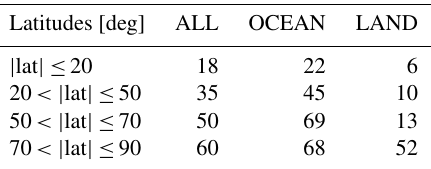
Table 2. Percentage of reflected signals within different latitudinal belts, and reflecting surface typology. Reflection is here defined as SVM output value > 0.25.